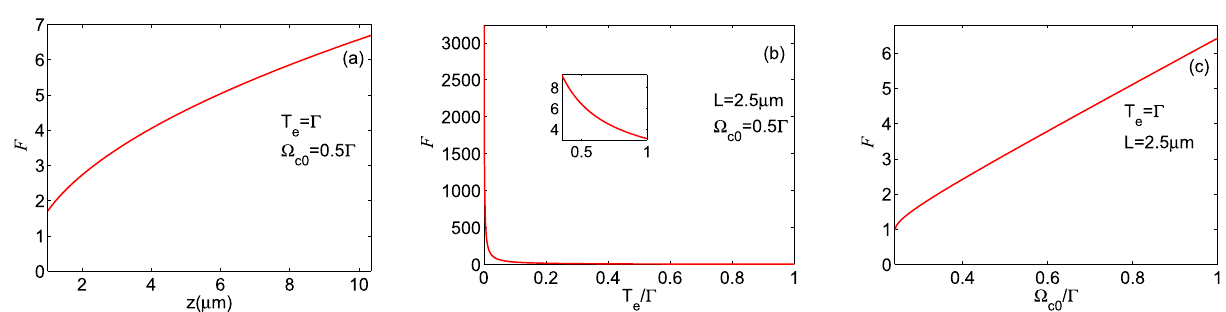
Figure 7. The finesse of fringes of the induced periodic waveform versus ( a ) medium length (for T e = Ŵ and � c 0 = 0.5 Ŵ ), ( b ) tunneling parameter (for L = 2.5 µ m and � c 0 = 0.5 Ŵ ), and ( c ) strength of the coupling field (for T e = Ŵ and L = 2.5 µ